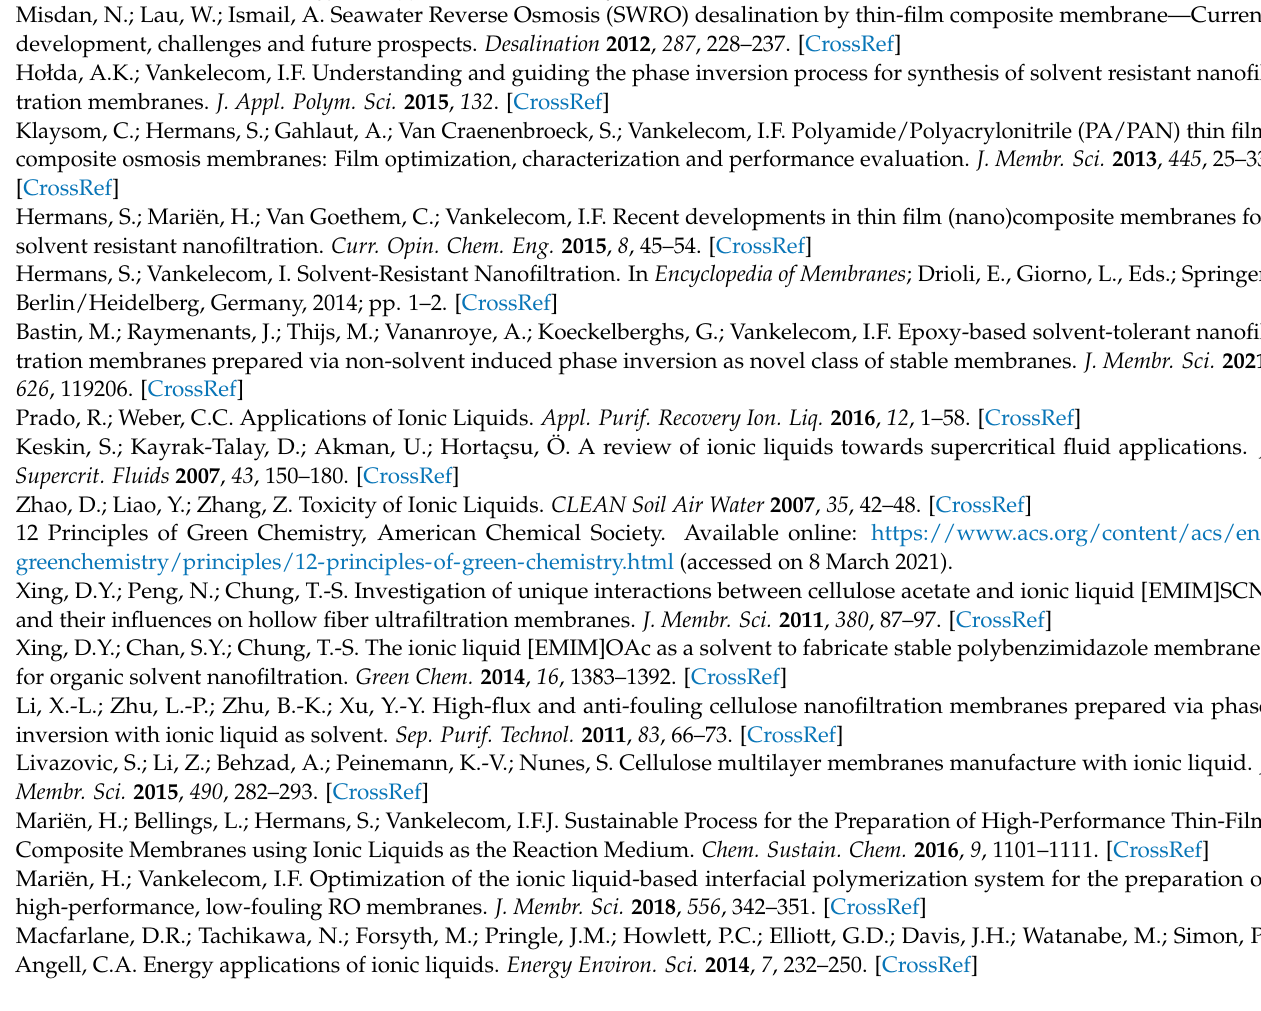
with TMHD. Figure S24: (a) Successful isolation of a poly( β -alkanolamine) film. (b) ATR-FTIR spectra of isolated poly( β -alkanolamine) film (dotted line) and pure BADGE (full line). Figure S25: Structure of poly( β -alkanolamine). Figure S26: ATR-FTIR spectrum of the obtained poly( β -alkanolamine) film (full line) and literature data (dotted line). Figure S27: ATR-FTIR spectra for (a) 10 wt% HDA in Table S2: Water content in dried co-solvents and Aliqaut/co-solvent mixtures. Table S3: Preliminary screening of poly( β -alkanolamine) film formation for three different concentrations of HDA and BADGE. Table S4: Vial tests for different concentrations of E2 and HDA. Table S5: Vial tests for different concentrations of E8 and